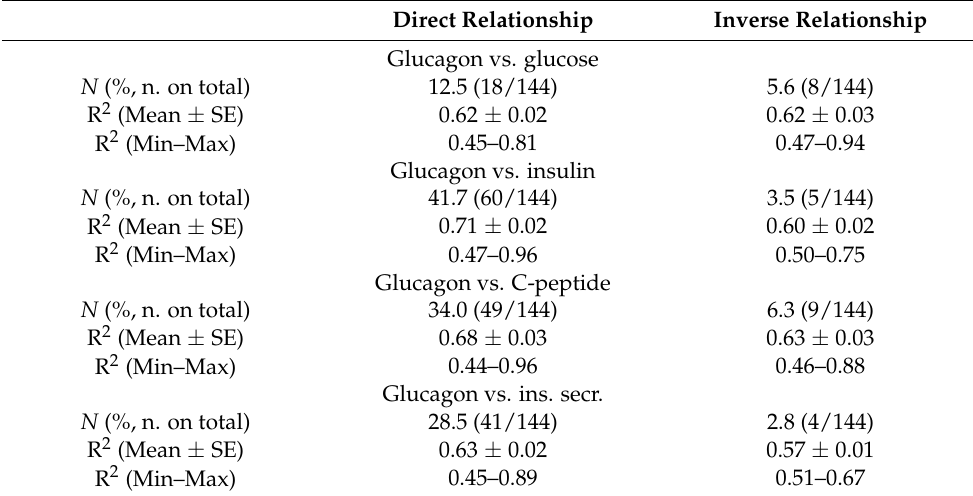
Table 3. Number of significant relationships (direct and inverse) between glucagon and glucose, glucagon, and insulin, as well as C-peptide and insulin secretion. R 2 values are also